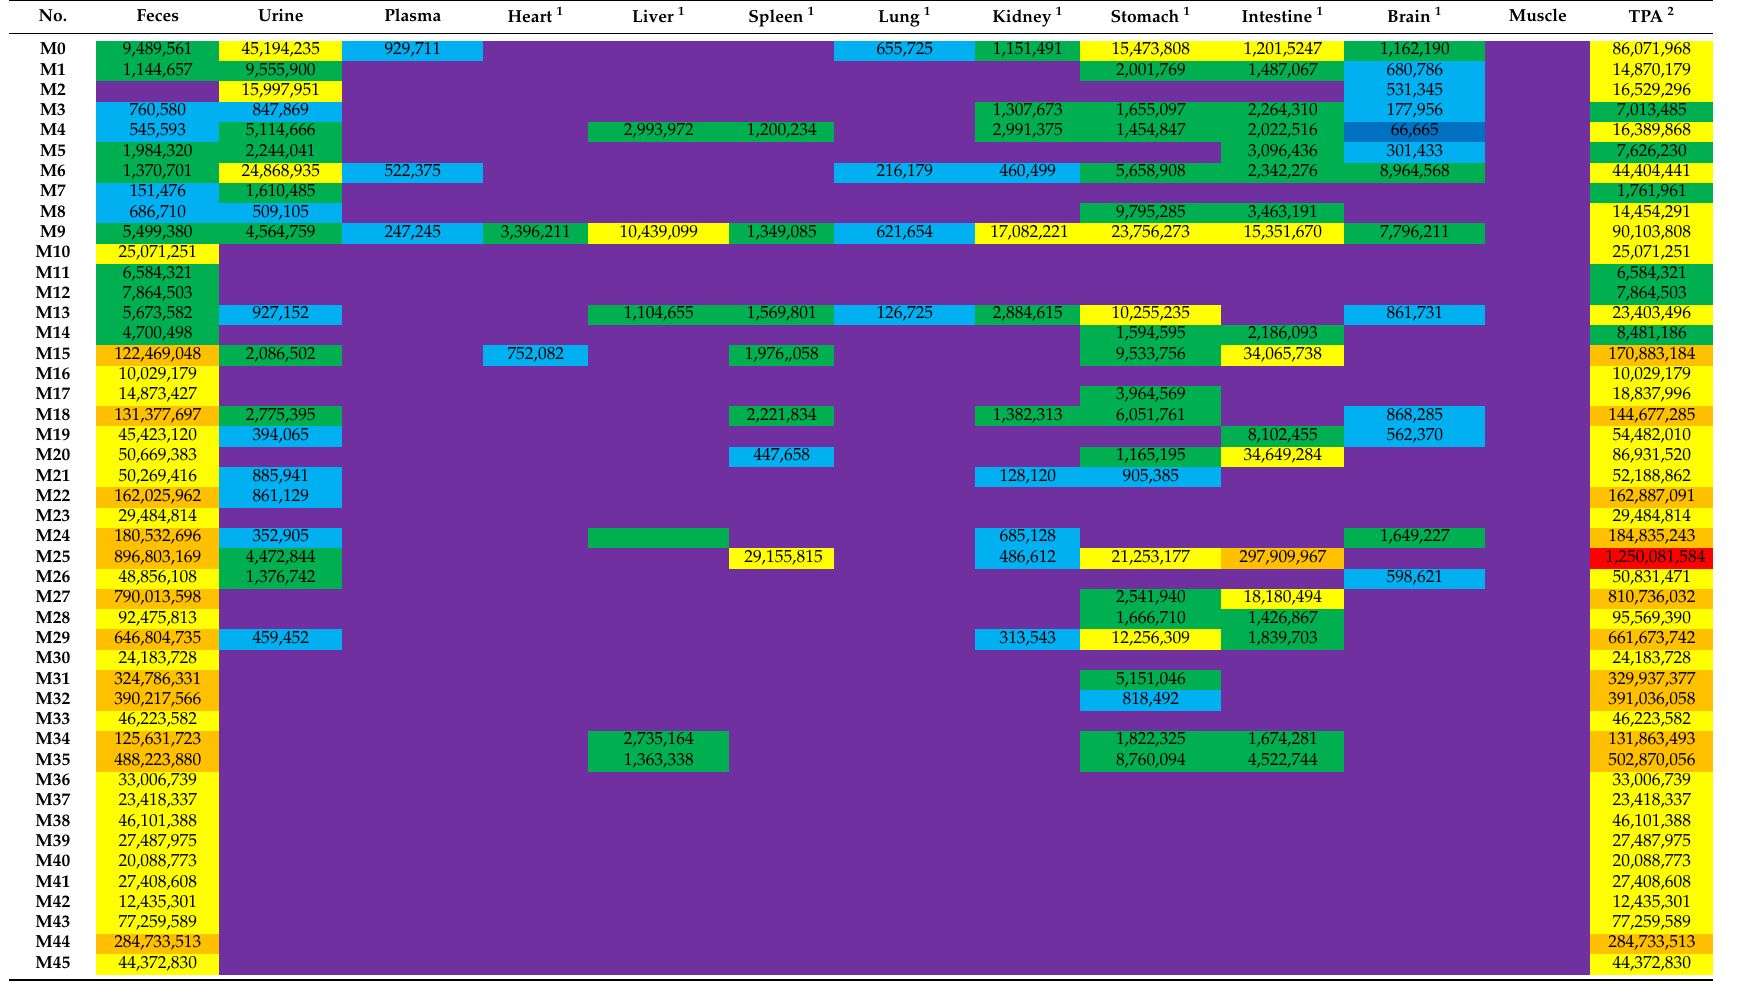
Table 2. Distribution of siamenoside I and its 86 metabolites in rat organs and their peak areas calculated from extracted ion chromatograms (EICs).